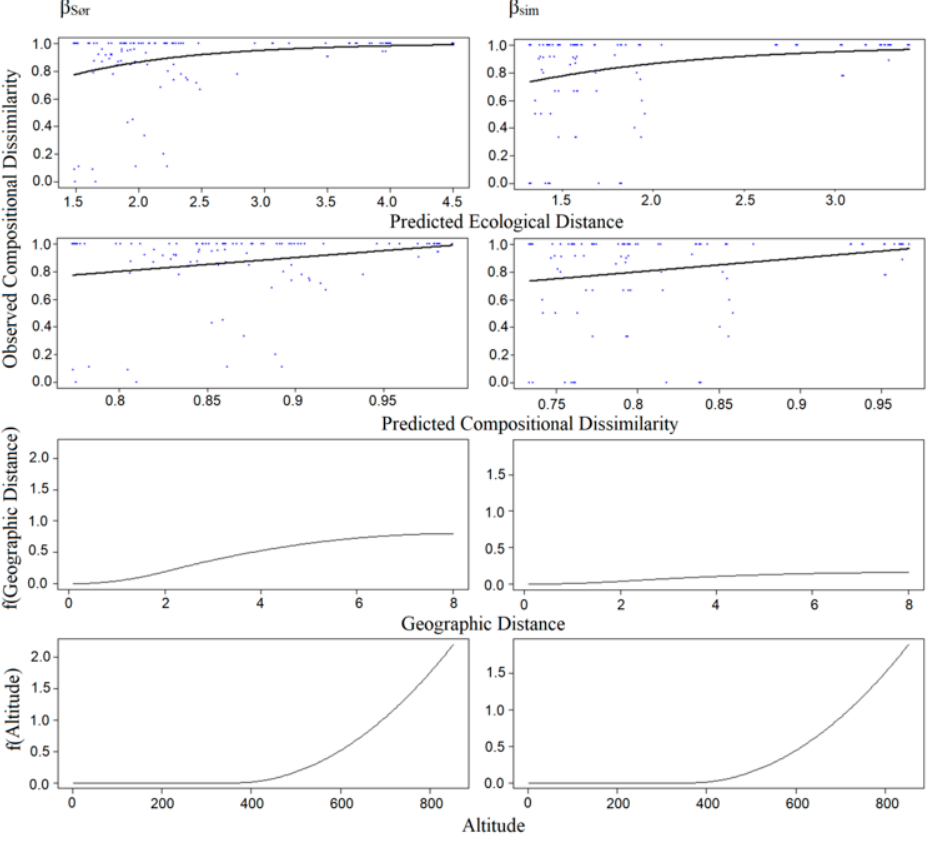
Figure 3. Relationships between the observed fish Sorensen dissimilarity ( β Sør ) and the observed fish Simpson dissimilarity ( β Sim ) with the regression equation from the Generalized Dissimilarity Model GDM (termed ecological distance) and the observed values versus the predicted dissimilarity. The fitted I-splines derived from the GDMs (partial regression fits) are shown for each predictor retained in the selected models, depicting the nonlinear rate across each environmental gradient (geographical distance and altitude). The maximum height reached by each curve indicates the total amount of compositional dissimilarity associated with that variable (it also indicates the relative importance of that variable in explaining beta diversity), holding all other variables constant. The shape of each function provides an indication of how the rate of compositional turnover varies along the gradient. Table 4. Summary of the Generalized Dissimilarity Model (GDM), in which significant variables and their relative importance in the GDMs are presented (relative importance is determined by summing the coefficients of the I-splines from GDM). The percentage of the total deviance explained by the fitted GDM and the null deviance are also presented.